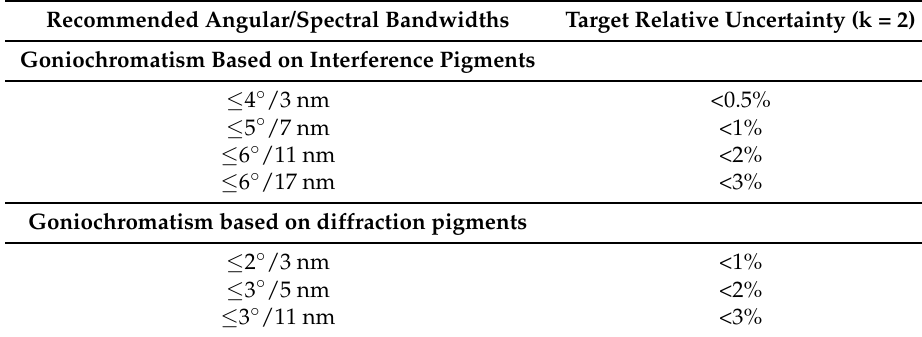
Table 1. Recommendations on spectral and angular bandwidths for measuring the spectral BRDF of goniochromatic coatings based on interference and diffraction